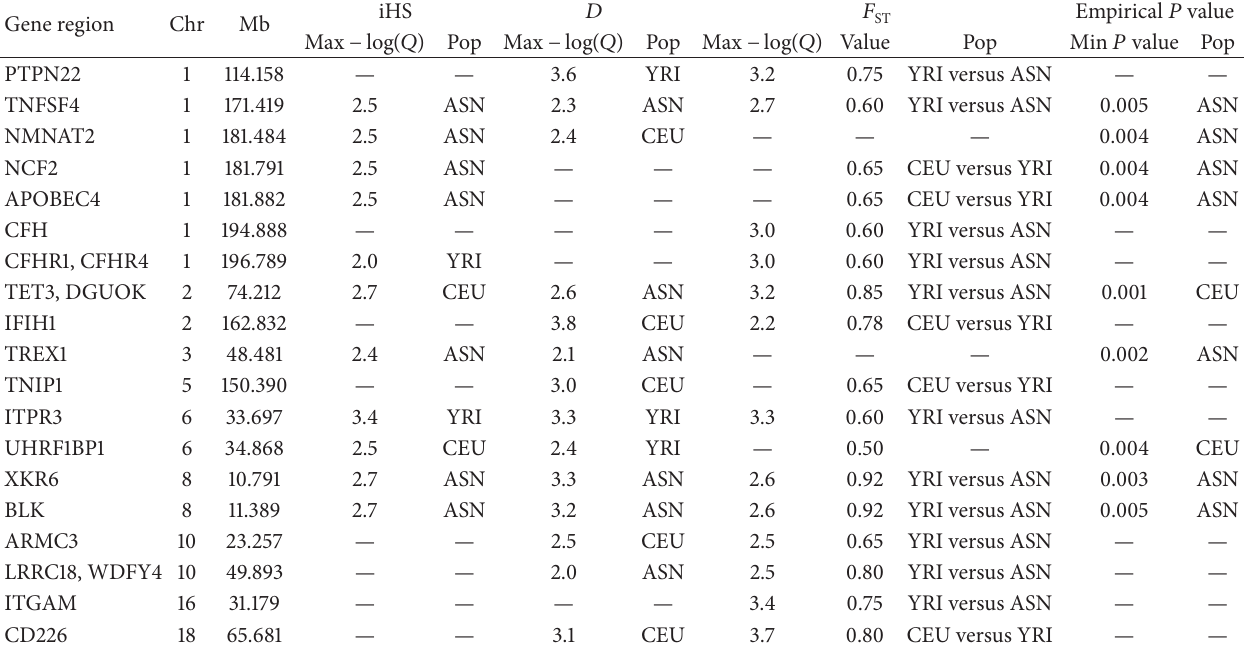
Table 2: Regions with evidence for selection on the HapMap populations.